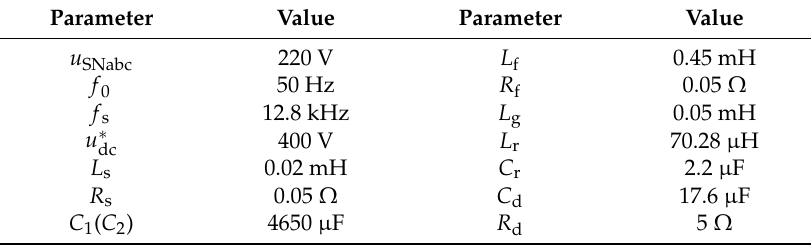
Table 1. Simulation parameters.